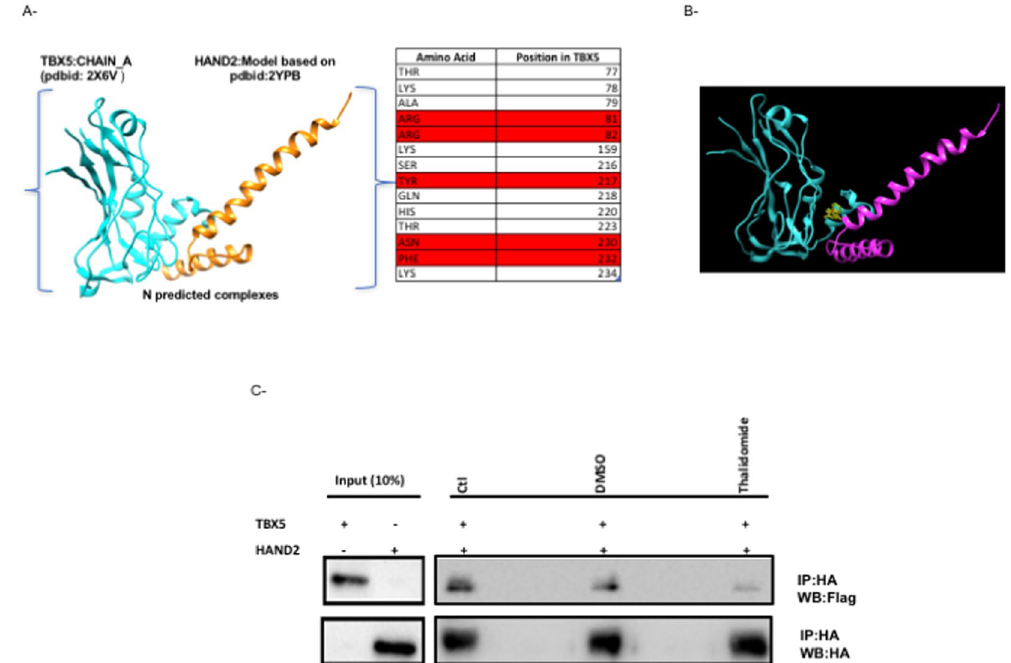
Figure 4. HAND2/TBX5 interaction drastically inhibited by Thalidomide. Protein-protein docking interface between TBX5 and HAND2 modeled DNA binding domain as retrieved from PDB. Only Residues of TBX5 within 5 angstroms of this interaction are shown ( A ). Those in red are associated with both TBX5-DNA and TBX5-HAND2 interaction from modeling simulation, which shows the position of thalidomide in the context of predicted TBX5-HAND2 interaction ( B ): TBX5 (cyan) and HAND2 (magenta). The physical interaction between both proteins was assessed by co-immunoprecipitation in the presence or absence ( − ) of either 4 µ M thalidomide or DMSO ( C ). Ten times the quantity of proteins loaded for western blot was used for immunoprecipitation. Nuclear lysates of both HAND2 and TBX5 were immunoprecipitated with anti‐HA antibody and HAND2 proteins were visualized by western blot with and anti‐flag antibody. Membrane stripping and subsequent western blot analysis was performed with anti‐HA antibody in order to detect TBX5 proteins. Quantitation of the bands showed more than 80% decrease in the interaction when the extracts were incubated in the presence of Thalidomide. (Ctr: control, WB: immunoblot, IP: